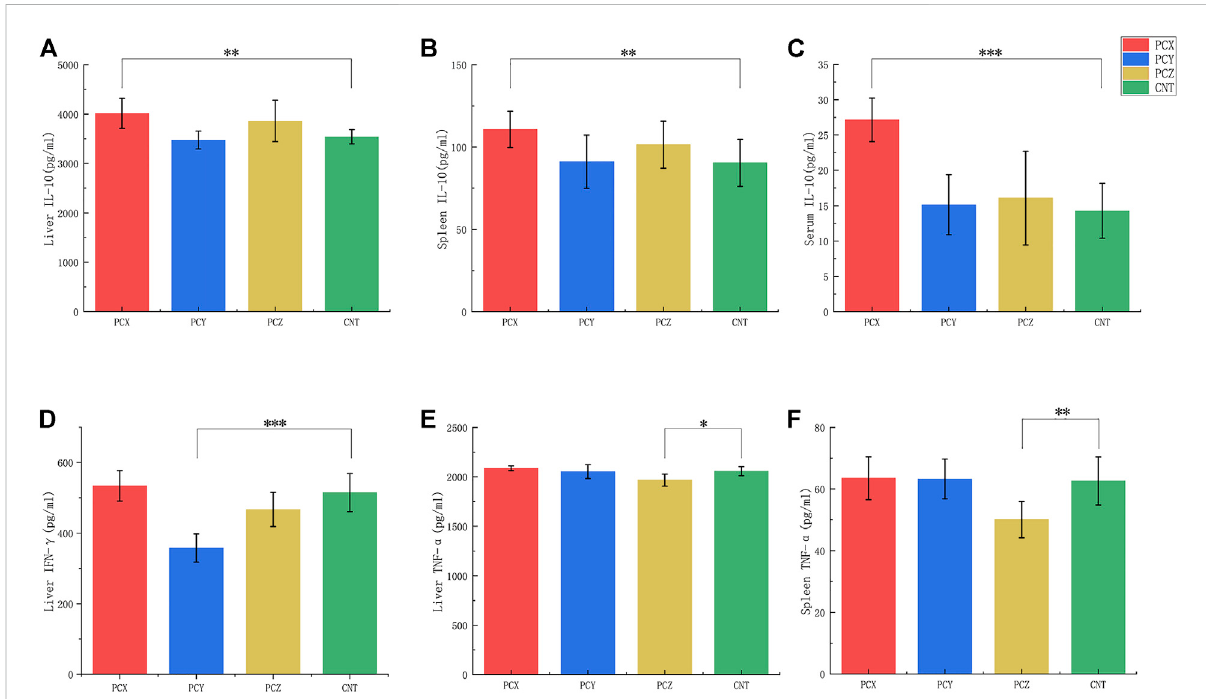
FIGURE 7 Levels of tumor necrosis factor- α (TNF- α ), interleukin 10 (IL-10), and Interferon gamma (IFN- γ ) in serum, liver, and spleen tissues. (A) Levels of IL-10 in liver tissues. (B) Levels of IL-10 in spleen tissues. (C) Levels of IL-10 in serum. (D) Levels of IFN- γ in liver tissues. (E) Levels of TNF- α in liver tissues. (F) Levels of TNF- α in spleen tissues. All values are mean ± SD, differences were considered statistically signi fi cant at * p < 0.05, ** p < 0.01, *** p < 0.001